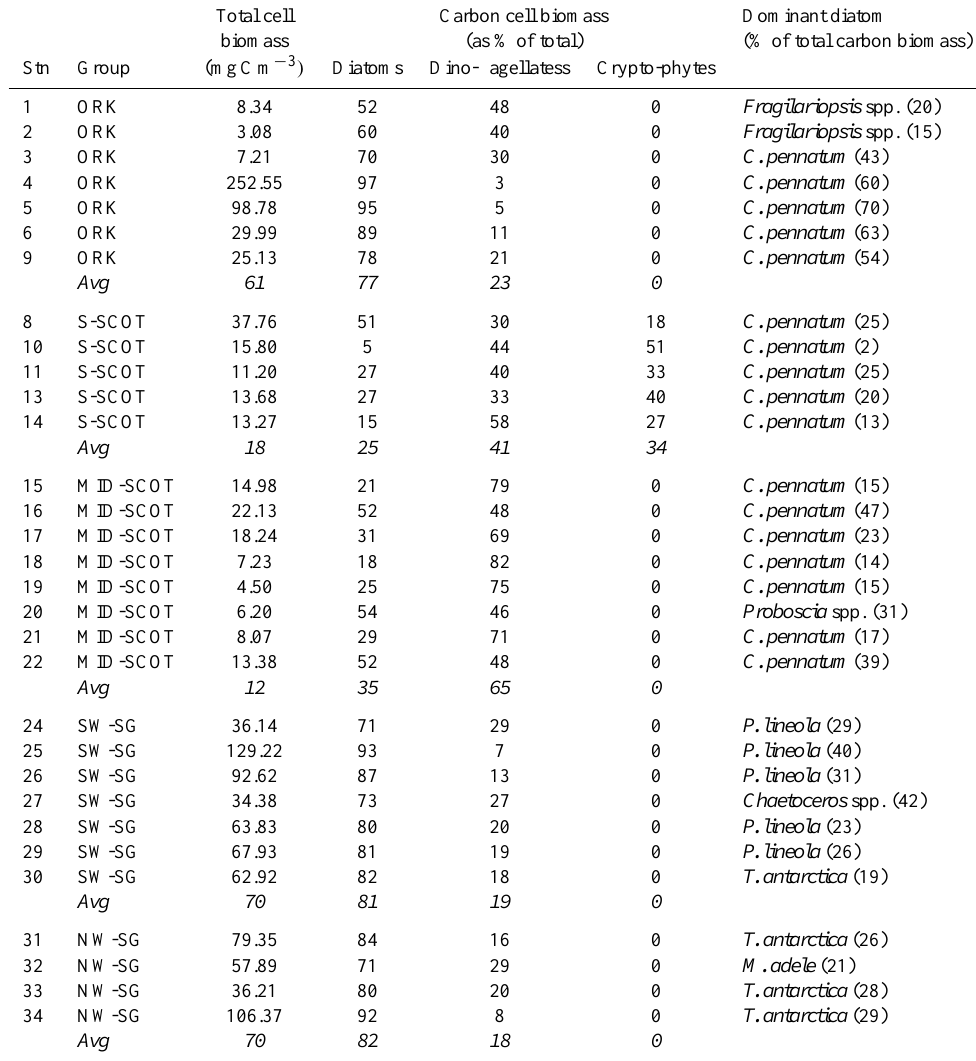
Table 3. Carbon biomass of the 2008 summer stations.